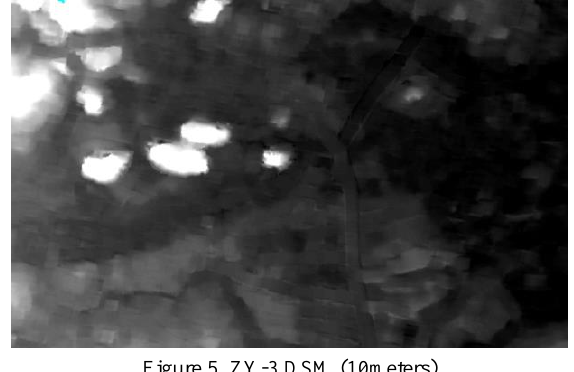
Figure 5. ZY-3 DSM (10meters)